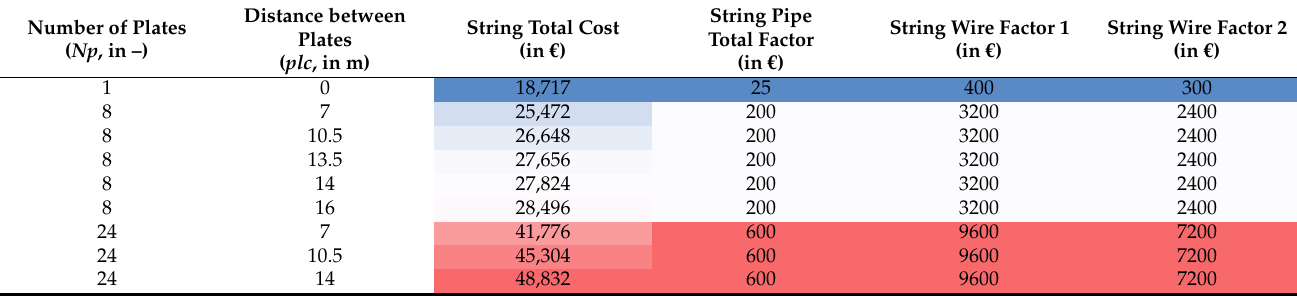
Table 9. String cost—Equation (8)—and their total factors obtained for the relevant parameters. The darkest red cell is the highest value per column, and the darkest blue reflects the lowest one. Number of Plates ( Np , in –)